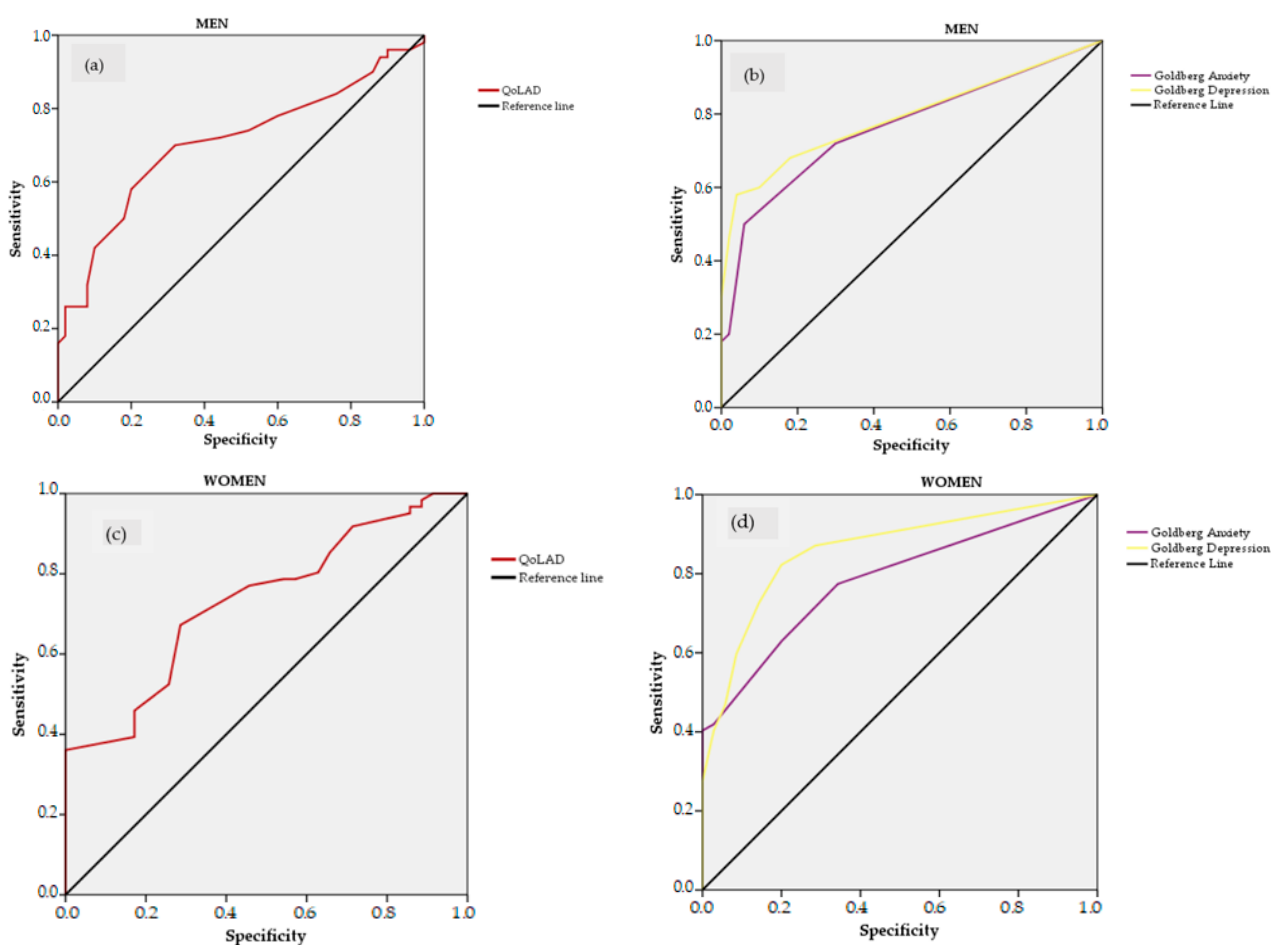
Figure 2. Receiver operating characteristic (ROC) curves to identify frailty by Fried Frailty Pheno- type (FFP) in men ( a , b ) and women ( c , d ) using different measures: Barthel Index, Timed Up and Go (TUG) test, Short Physical Performance Battery (SPPB) score, Quality of Life in Alzheimer’s Disease (QoLAD), and Goldberg Anxiety and Depression scales. ROC curves of TUG test (for men and women) and Goldberg Anxiety and Depression scales (for women) have been plotted inverted for better comparison.